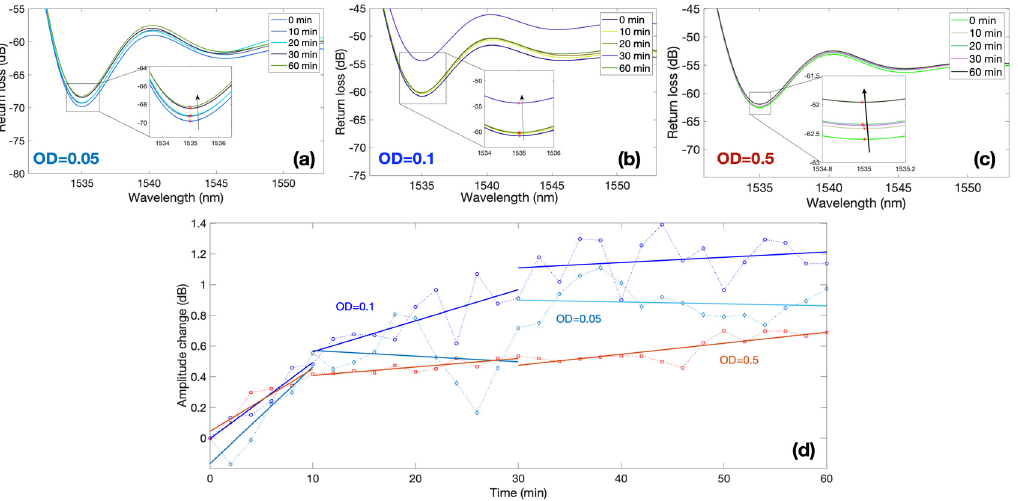
Figure 5. Spectral response of ball resonators in different bacteria concentrations; the charts report the response of three different sensors with sensitivity values − 127.52, − 144.28 and − 104.46 dB/RIU at different values of OD recorded over 60 min period. ( a – c ) Reflection spectra of each sensor for different measurement times for OD equal to 0.05 ( a ), 0.1 ( b ), and 0.5 ( c ). Insets of each figure show the spectral valley used for the intensity level tracking. ( d ) Normalized response for each sensor, reporting the amplitude change over time; the response of each OD is separated into 3 regions: 0–10 min, 10–30 min, 30–60 min.